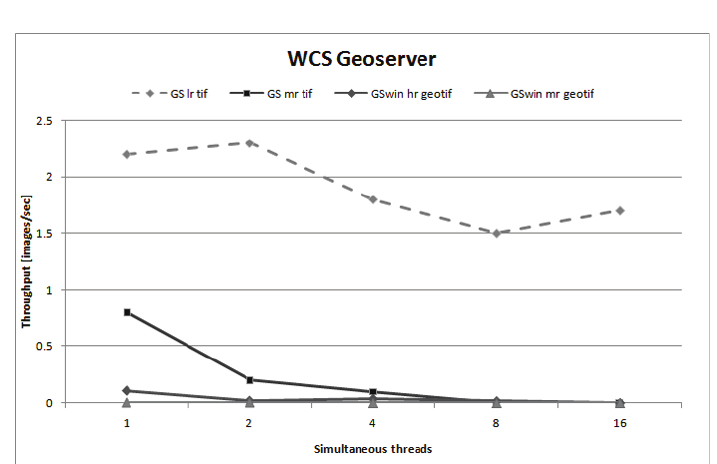
Figure 7: WCS Geoserver tests